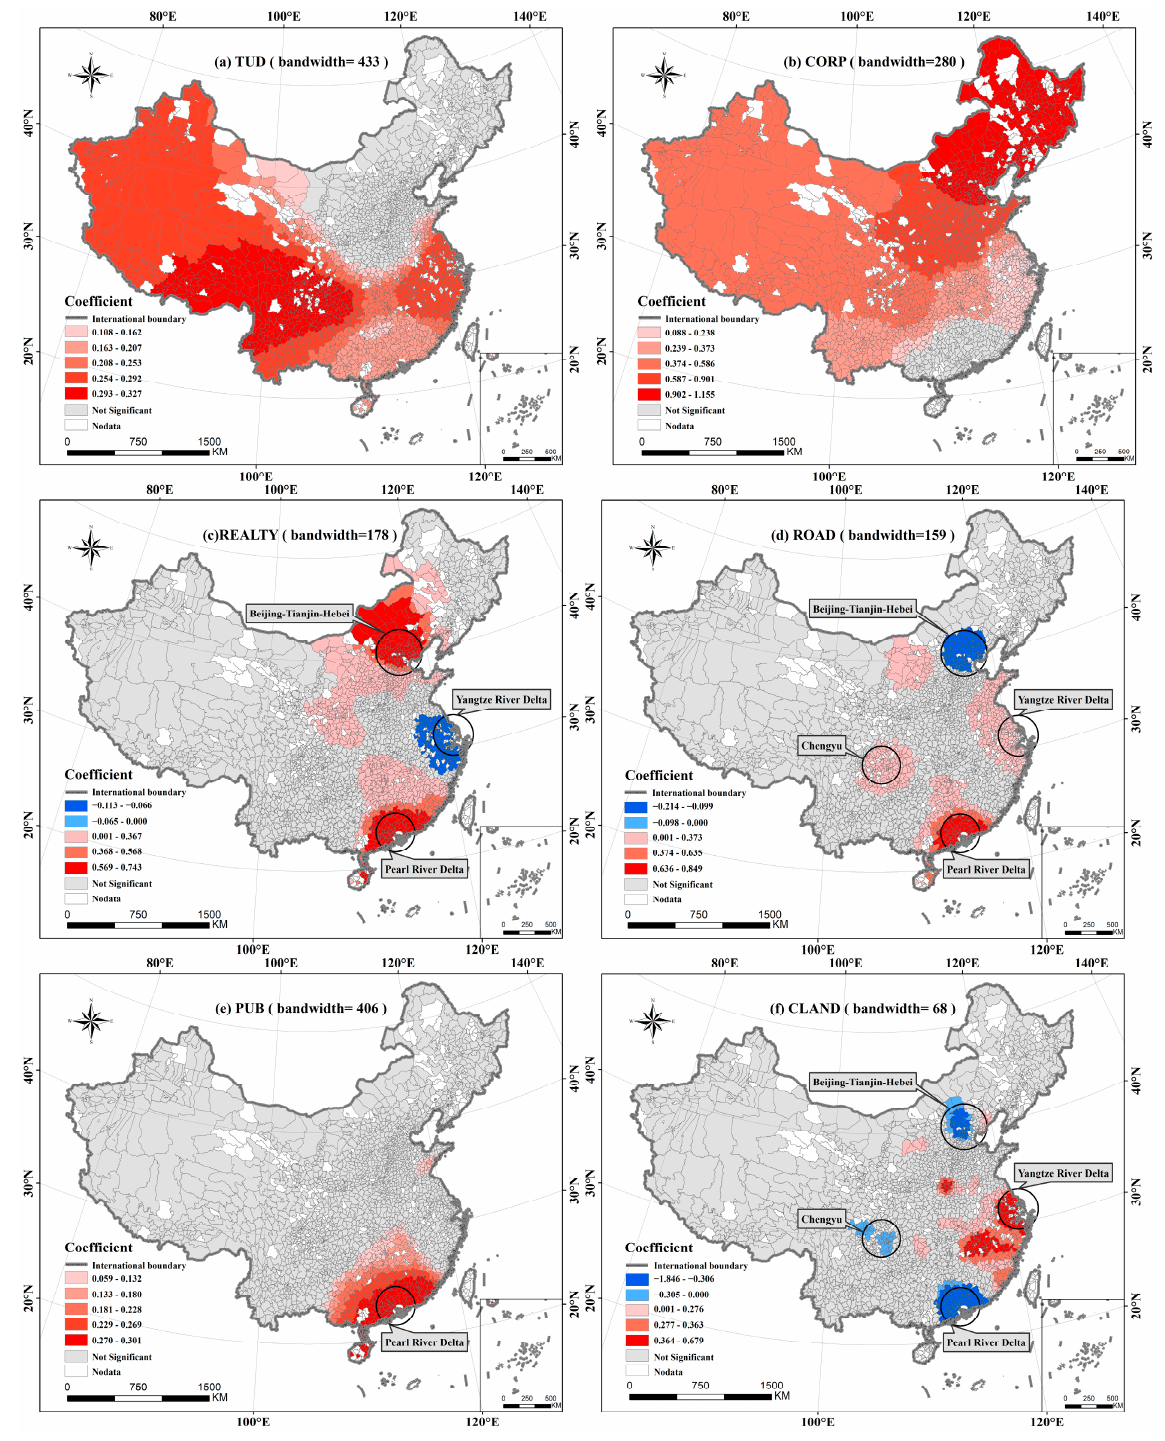
Figure 7. The spatial distribution of factors affecting the distribution of county economic develop- ment in